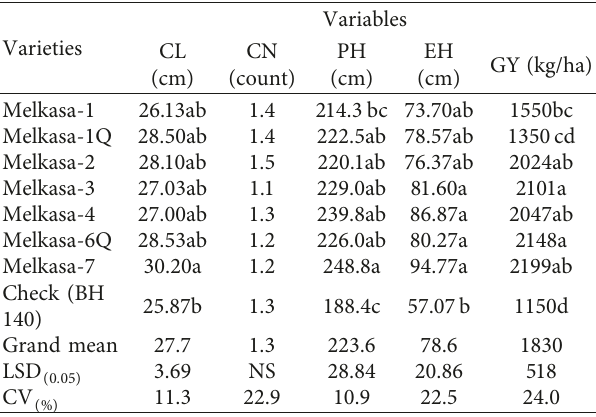
Table 5: Mean values of agronomic traits for maize varieties at Salayish and Angila-4 locations during 2017 in Basketo special and Melokoza districts, Southern